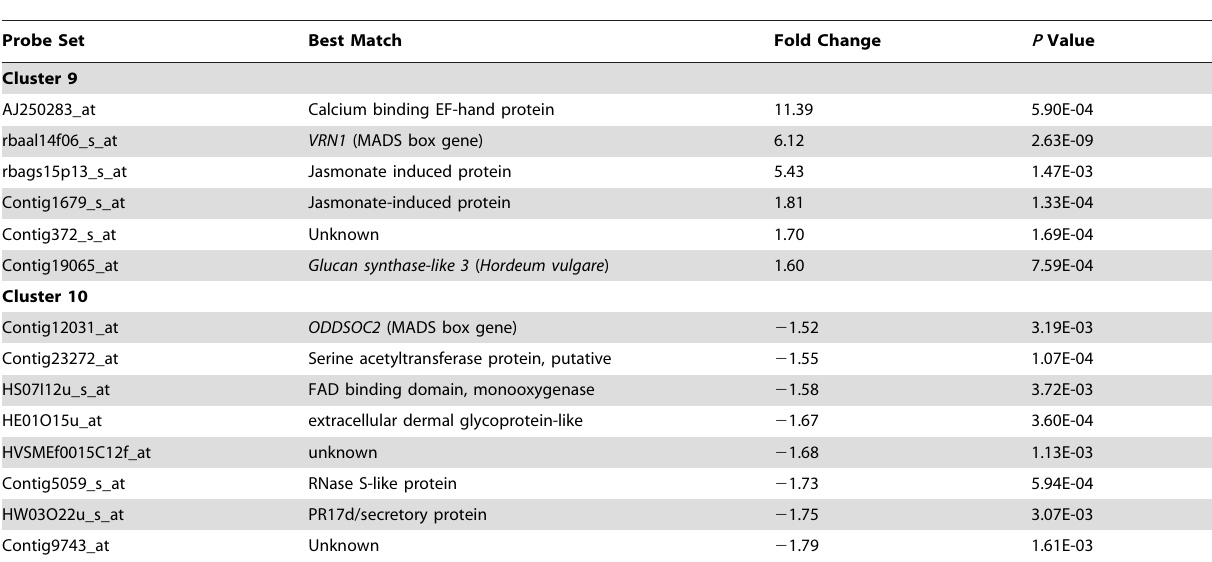
Table 1. Contigs that show a lasting response to cold in the leaves of vernalized plants.